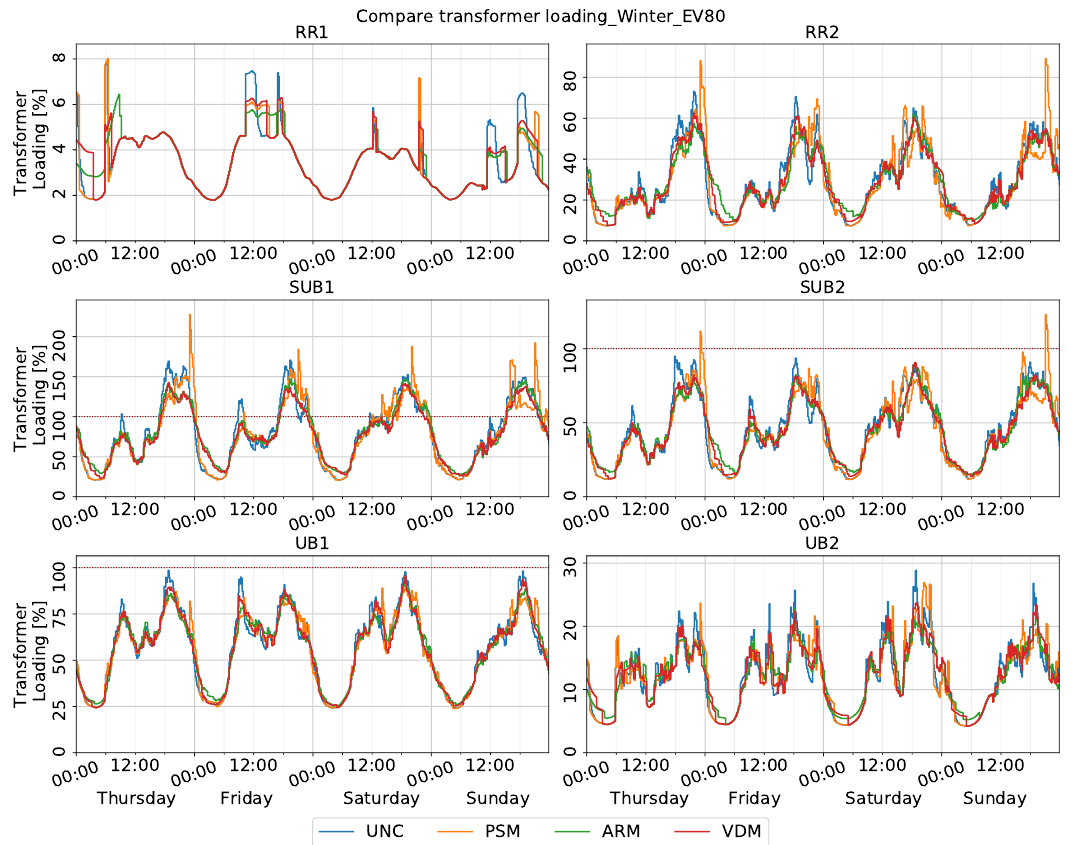
Figure 6. Comparison of transformer loading versus time of three methods with 80% EV penetration in winter.